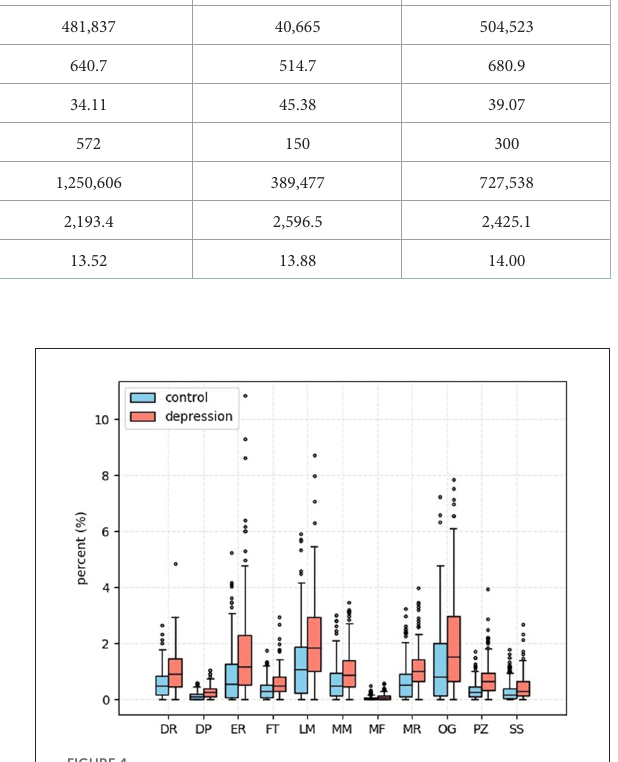
FIGURE4 This is a boxplot of various cognitive distortions. The vertical axis is the percentage of total information, and the horizontal axis is the abbreviation for the type of cognitive